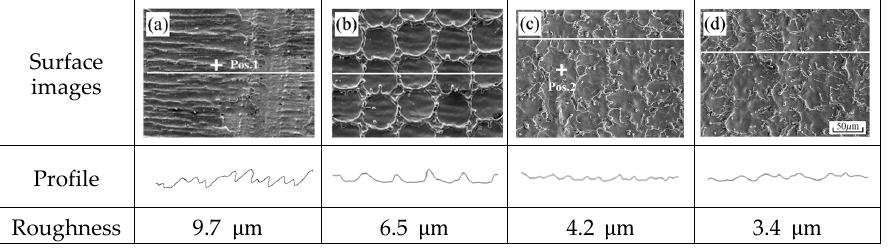
Figure 4. SEM images, profile and roughness of the surface before and after laser cleaning according to energy density and 1 and 2 positions of EDS spot analysis; ( a ) Before laser cleaning, ( b ) 3 J/cm 2 , ( c ) 5 J/cm 2 , ( d ) 7 J/cm 2 .